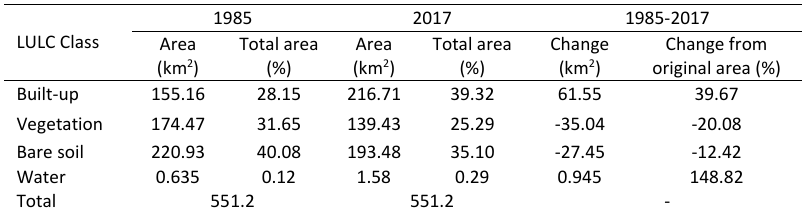
Table 2. Area of land-use/land-cover classes (1985 and 2017) in Table 2: Area of land-use/land-cover classes (1985 and 2017) in Isfahan LULC Class